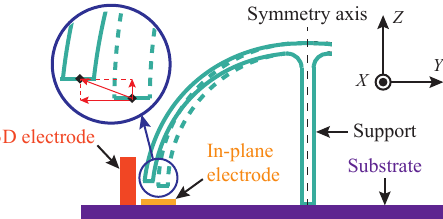
Figure 3. Implementations of the in-plane electrodes and the out-of-plane electrodes for the MHR.